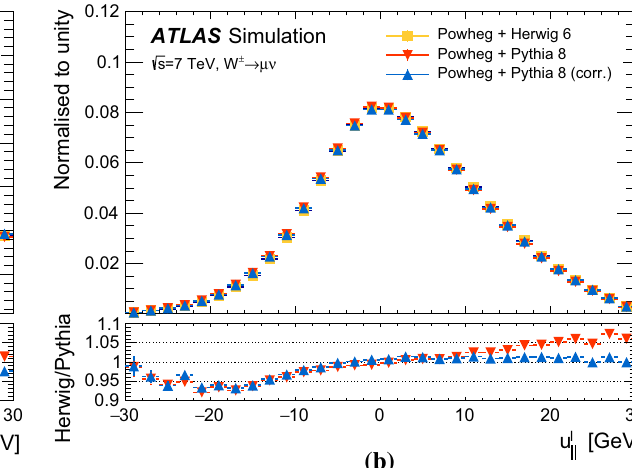
to that of Powheg+Herwig 6 . The lower panels show the ratios of Powheg+Herwig 6 to Powheg+Pythia 8 , with and without the recoil response correction in the Powheg+Pythia 8 sample. The discrepancy remaining after recoil corrections reflects the different p W distributions T